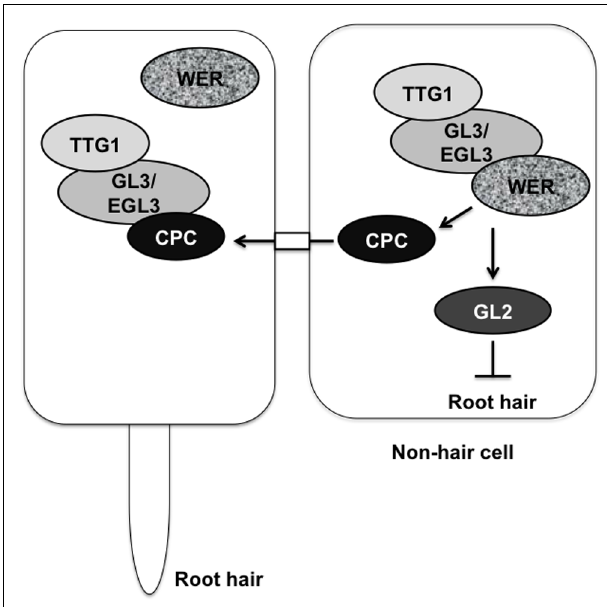
FIGURE 1 | Regulation of root-hair cell and non-hair cell fate determination by transcription factors. TheTTG1-GL3/EGL3-WER complex promotes GL2 and CPC expression.The cell expressing GL2 differentiates into a non-hair cell.The CPC protein moves from the non-hair cell to a neighboring cell and competes withWER for binding to GL3/EGL3. TheTTG1-GL3/EGL3-CPC complex cannot promote GL2 expression, resulting in the differentiation of a root-hair